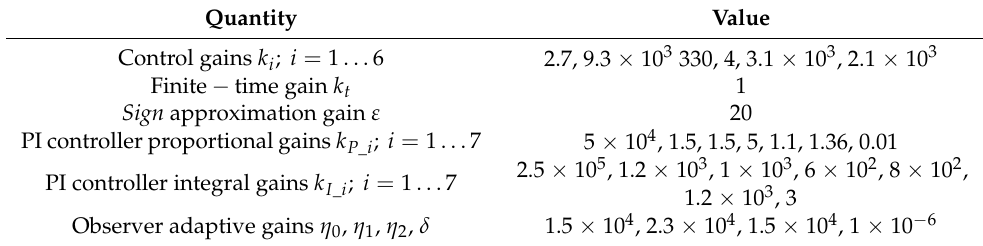
Table 3. Parameters of the controllers and the